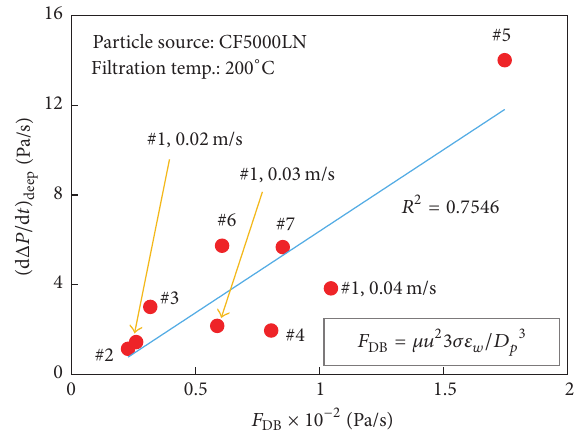
Figure 8: The relationship between ( d Δ𝑃/ d 𝑡) initial and 𝐹 DB .